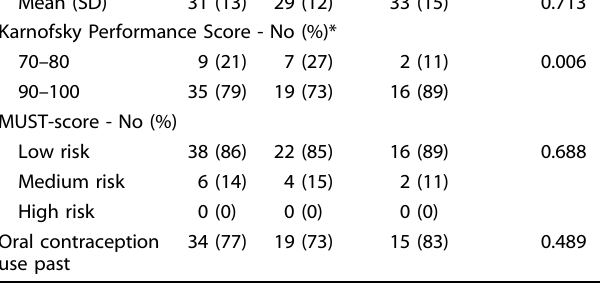
(Supplementary Table 9). Principal component analysis (PCA) showed large heterogeneity in individual microbial community structures. Permutational analysis of variance (PERMANOVA) revealed that there was no statistically signi fi cant association between overall microbial community structure at phylum ( p = 0.086) and genus ( p = 0.102) level and the different sampling time points (Fig. 4).